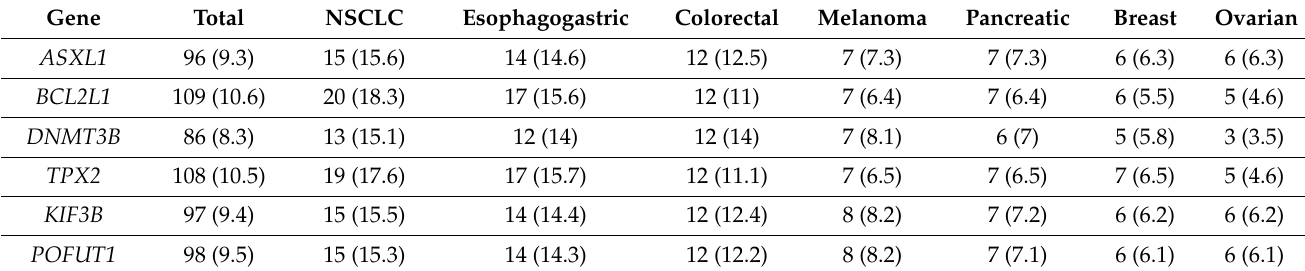
Table 2. Number of cell lines from different types of cancers with amplifications of genes located at chromosome 20q11.21. In parentheses are percentages of the total number of cell lines from each type of cancer included in